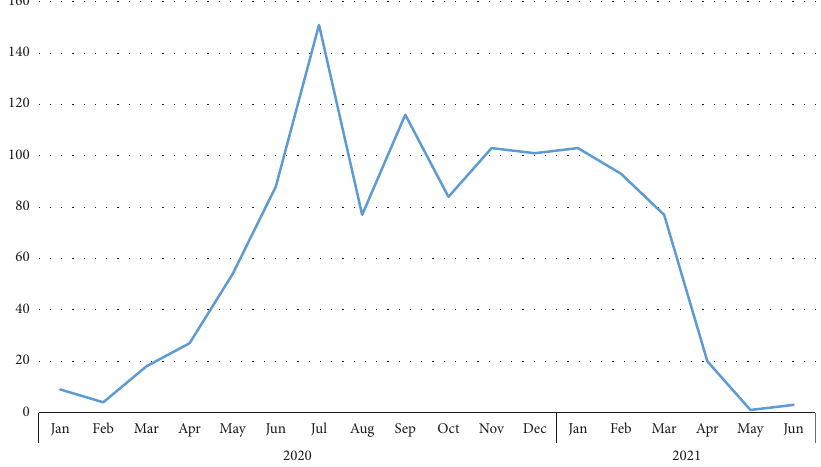
Figure 3: The number of publications by the year and month they were